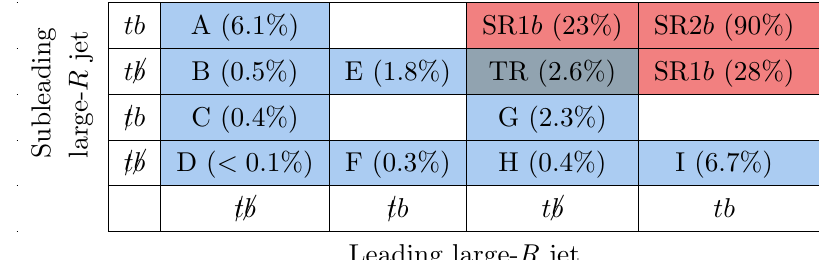
Table 1. Event categorization used to model the multijet background from data according to whether the leading and subleading large- R jets are top-tagged or b -tagged. If the large- R jet is top-tagged, it is denoted by t , and otherwise by (cid:3) t , as indicated in the left column or in the bottom row. Similarly, if the large- R jet is b -tagged, it is denoted by b , and otherwise by (cid:1) b . The percentages in parentheses show the expected fractions of SM t (cid:22) t events obtained using the t (cid:22) t and multijet simulation samples. Non- t (cid:22) t or non-multijet background events are negligible. The signal regions, SR1 b and SR2 b , are coloured in red, the template region (TR) in grey and the rest of the control regions A-I in light